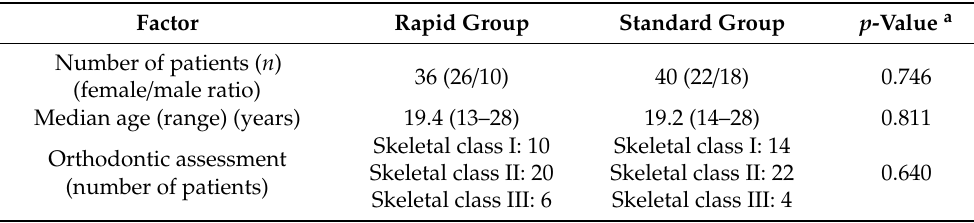
Figure 1. The flow chart of participation diagram. Table 1. General characteristics of cancer survivors and control group of